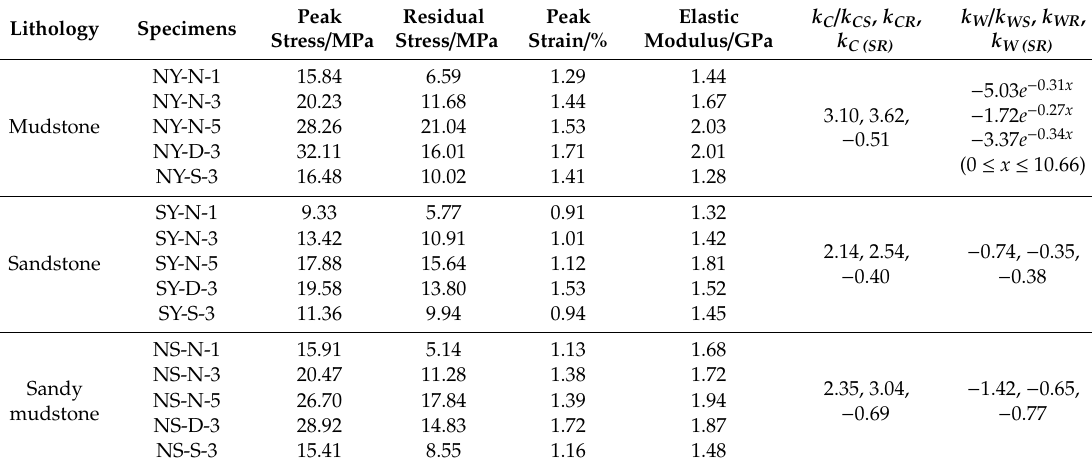
Table 2. Key test results.